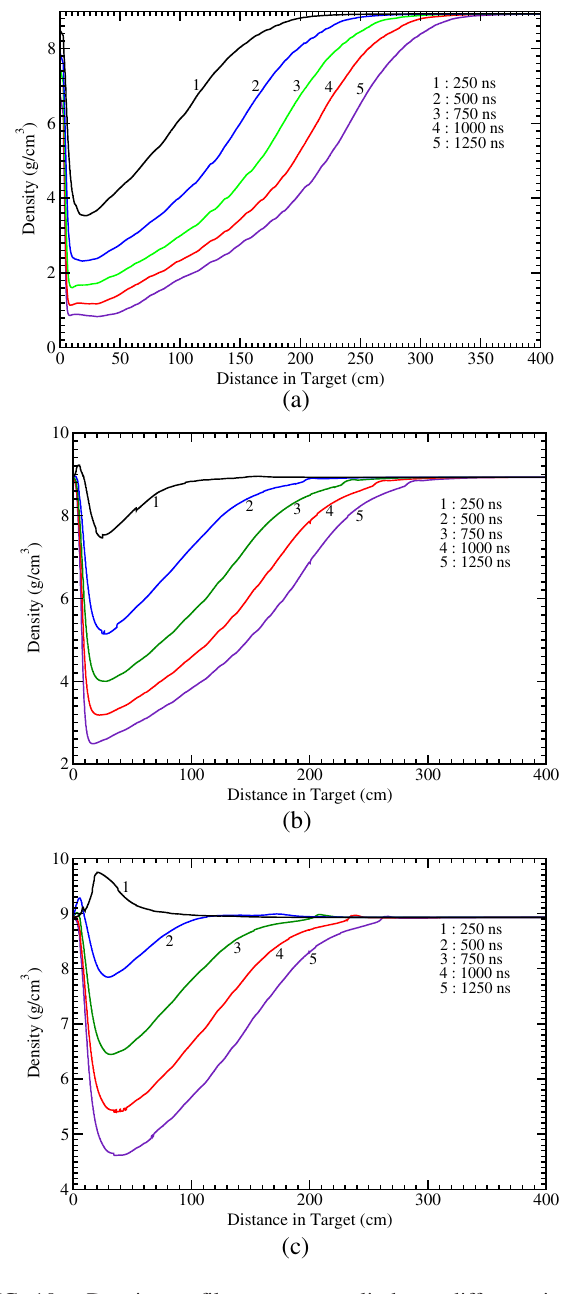
FIG. 10. Density profiles vs target cylinder at different times: (a) along the axis at r ¼ 0 , (b) at r ¼ 1 mm, and (c) at r ¼ 2